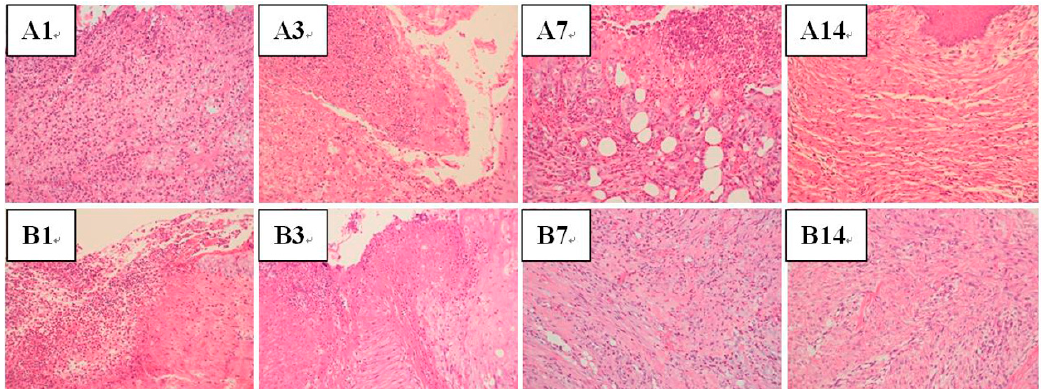
Figure 8. Histological images of ( A ) control group and ( B ) nanofibrous composite membrane group on Days 1, 3, 7 and 14. Polymorphonuclear neutrophils (PMN) infiltration was moderate in the drug-eluting membrane treated wounds, while the wounds in the control group showed heavy PMN infiltration on Day 7.